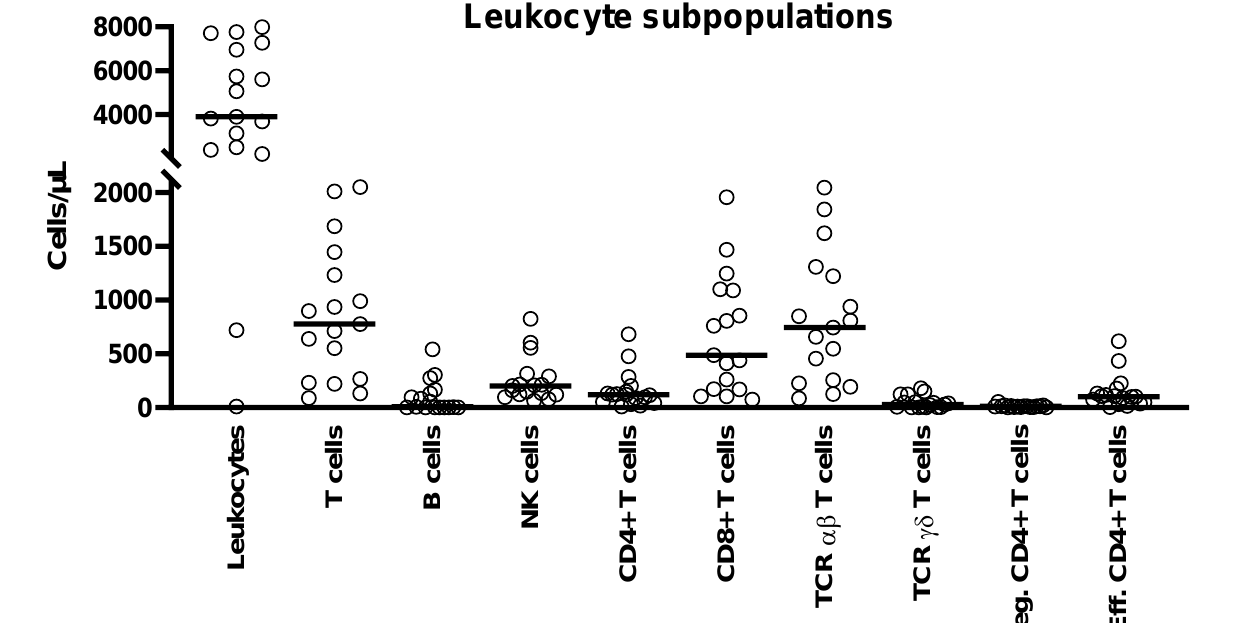
Figure A3. Distribution of leukocyte subpopulations in the patient cohort shown in Table A1. This